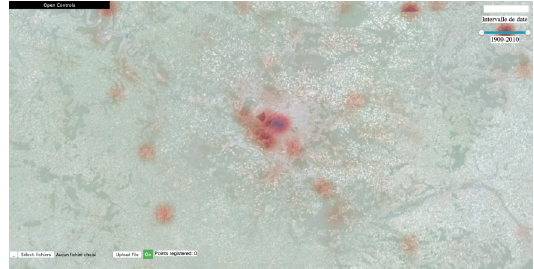
Figure 8. Multi-scale visualization of localized images with heat map, over Paris area.